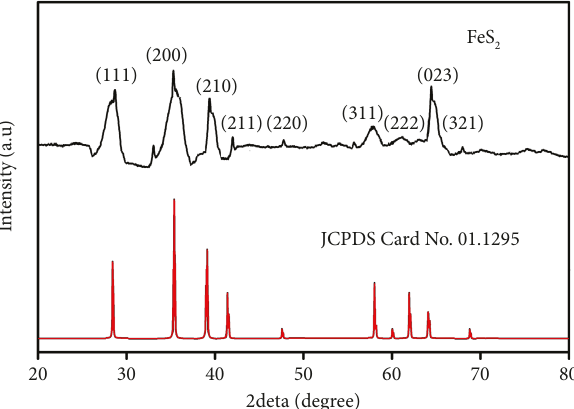
Figure 4: XRD examination-synthesized FeS